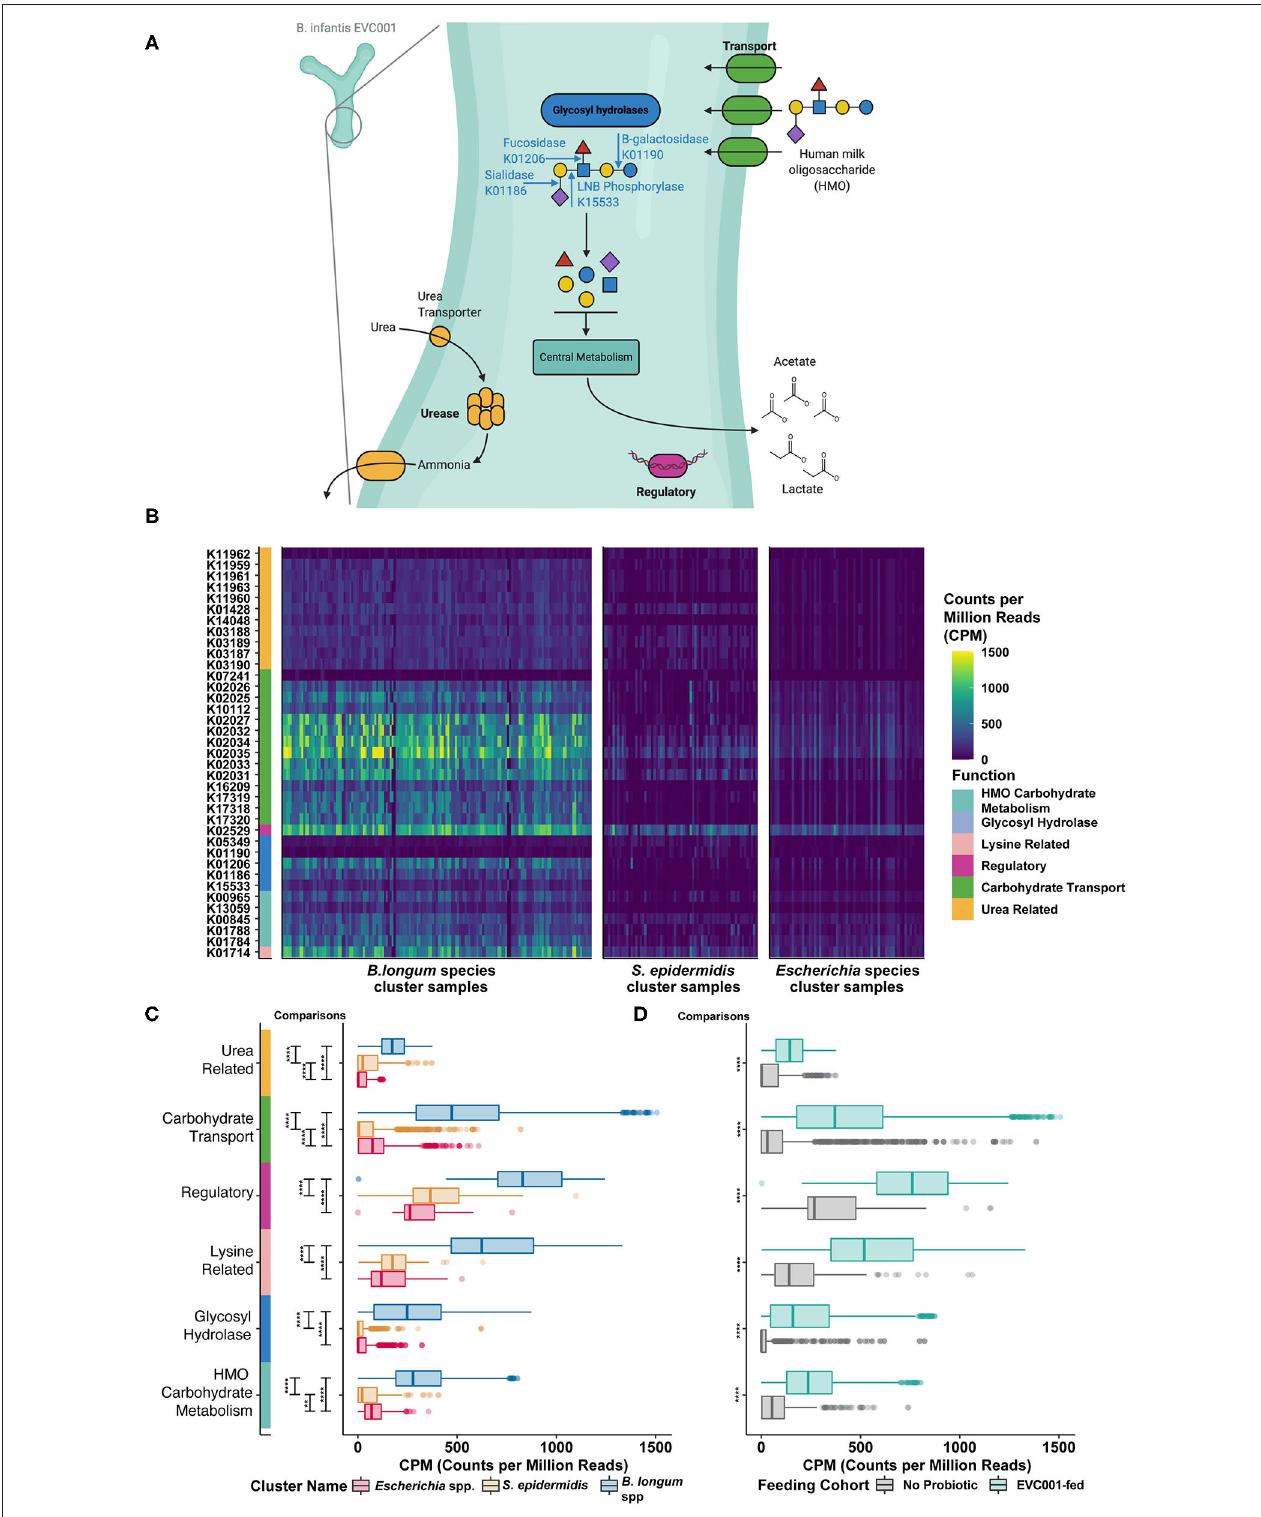
FIGURE 4 | Human milk oligosaccharide (HMO) utilization in B. infantis and the enrichment of HMO-utilizing functions among infants fed B. infantis EVC001. (A) Bifidobacterium longum subsp. infantis ( B. infantis ) utilizes a suite of human milk oligosaccharide (HMO)-associated gene loci to transport intact HMO structures into the cell, where intracellularly located glycosyl hydrolases (blue) break down linkages found commonly among HMO structures. Other enzymes involved in central